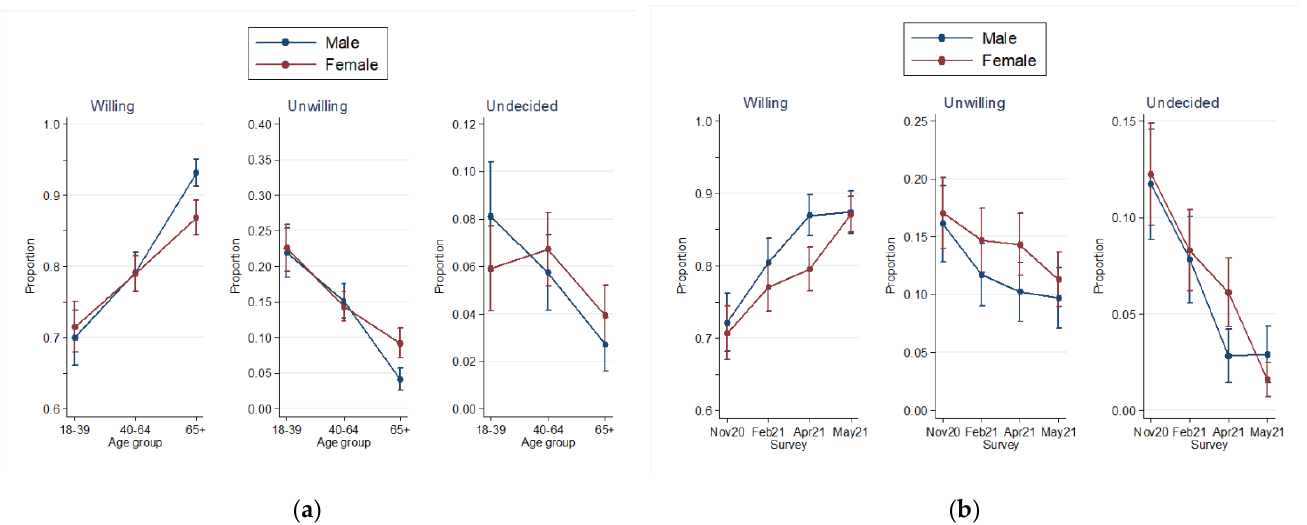
Figure 2. Adjusted predictions of willingness, unwillingness and uncertainty about being vac- cinated: ( a ) effect of age according to the gender of respondents; ( b ) effect of survey period according to the gender of respondents.